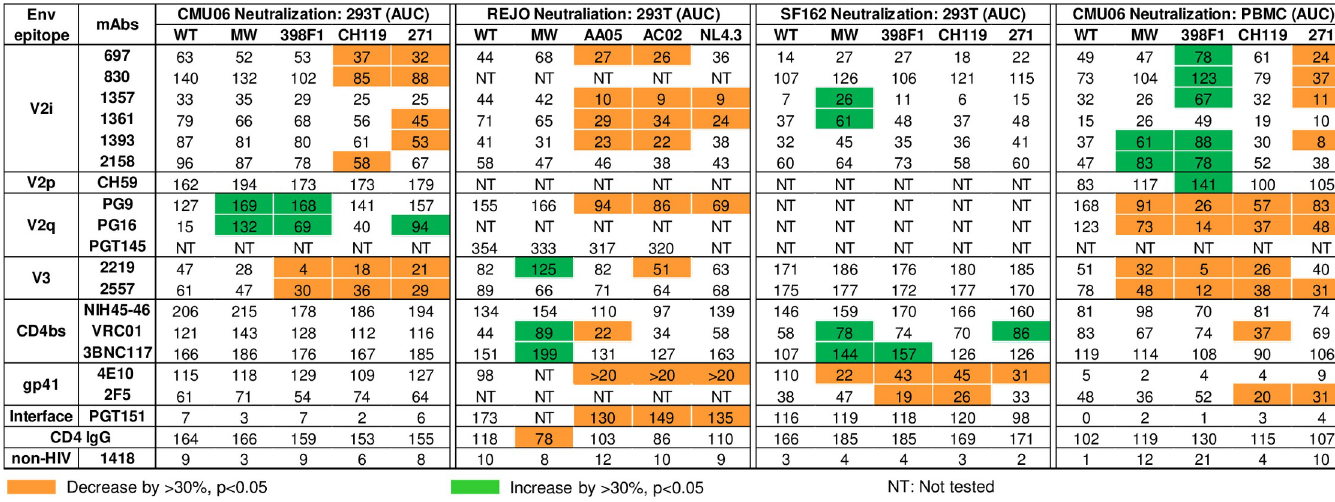
Fig 8. Neutralization AUC values of WT and SP-swapped viruses grown in 293T cells and PBMCs. AUCs values that decreased or increased by > 30% and had p < 0.05 relative to WT for the same MAbs or CD4IgG are shown in orange or green, respectively. NT: not tested.